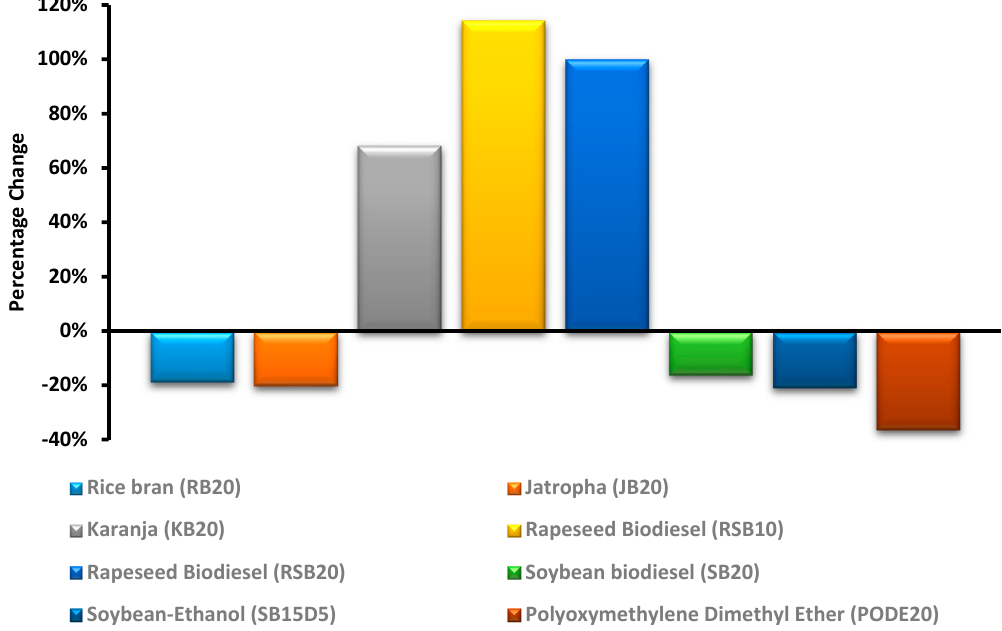
Figure 1. Percentage changes in particulate mass (PM) for different fuels for cold-start as compared with hot-start of engine [17,64,101,102,130,131].